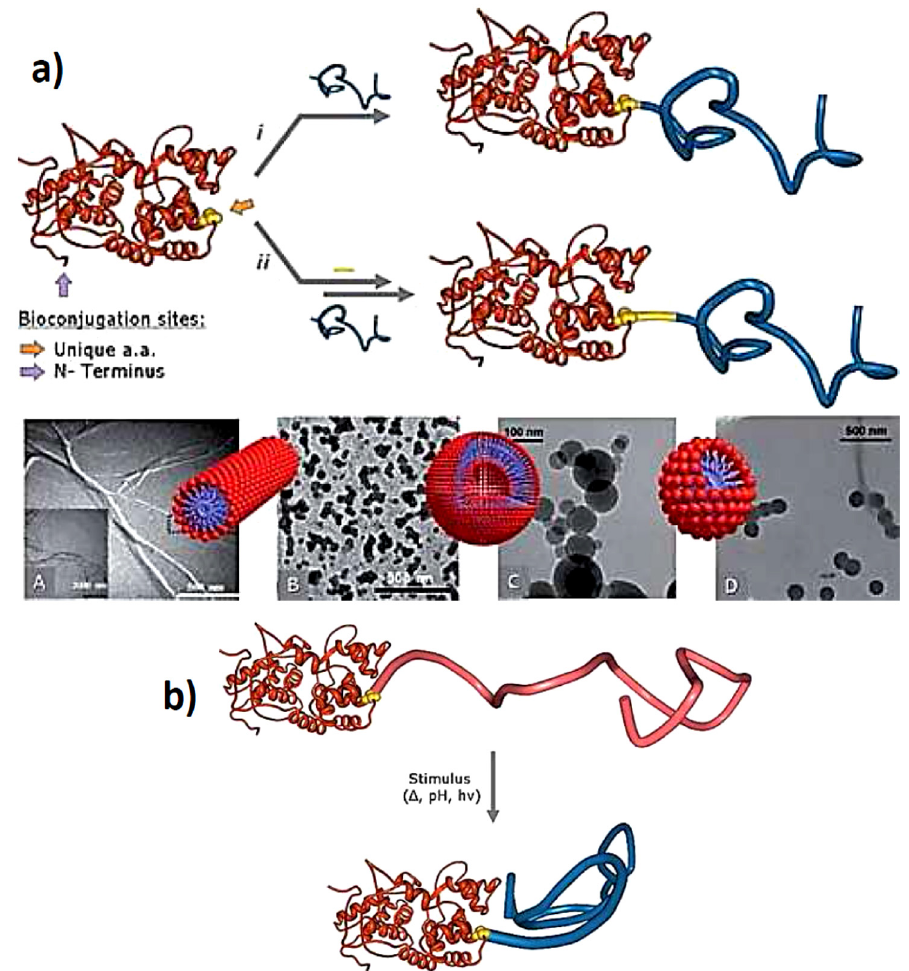
Figure 5. ( a ) (A) schematic representation of the ‘‘grafting to’’ synthesis of Giant Amphiphiles through the i direct and ii indirect bioconjugation approach.